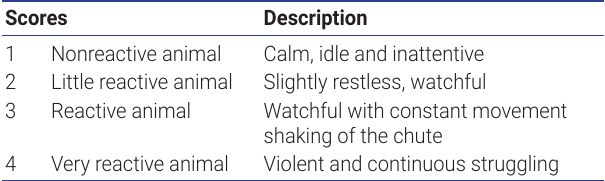
Table 1. Subjective score